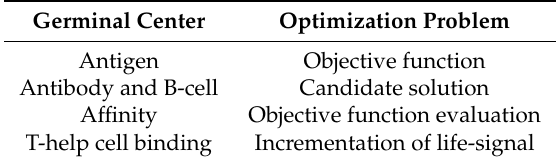
Table 1. Computational analogy between Germinal Center (GC) and